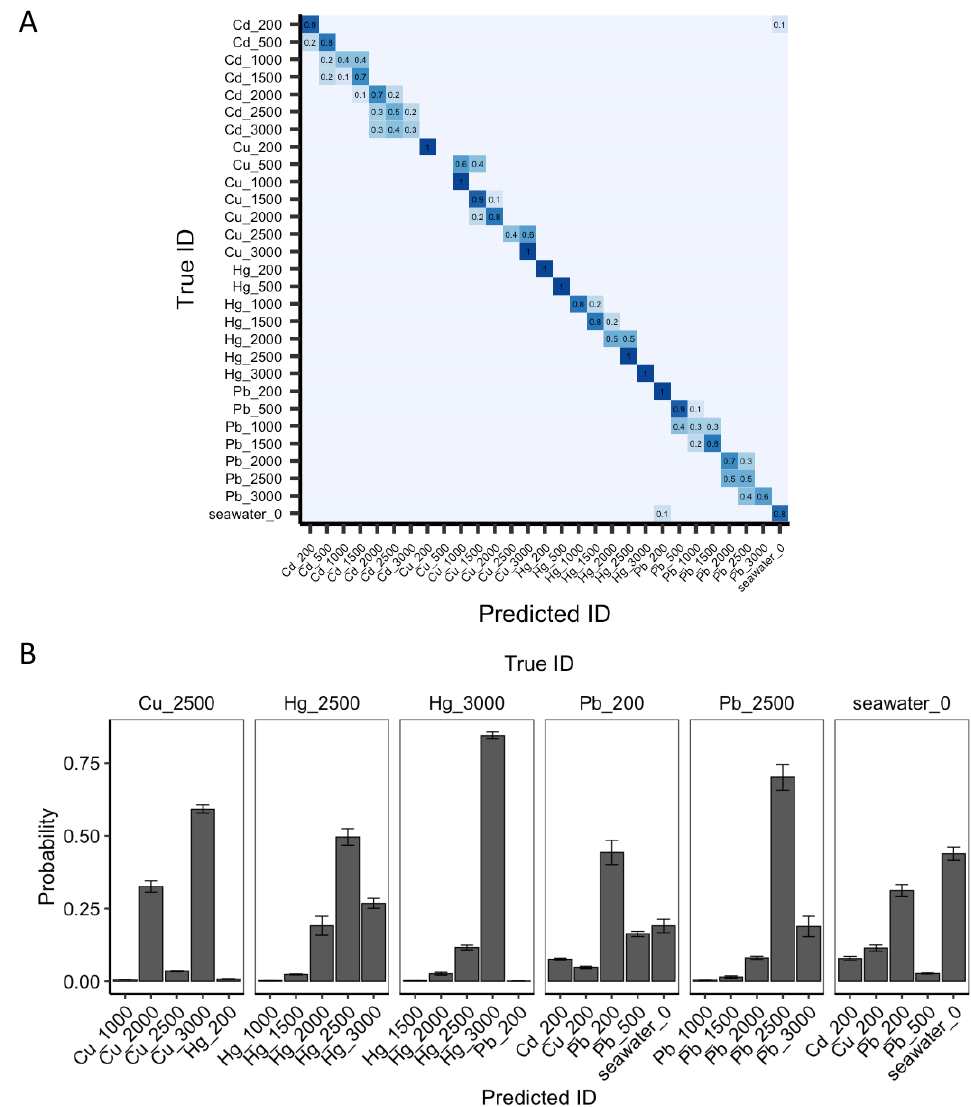
Figure 8. ML model prediction of concentration using oxygen modified hydrogen-intercalated QFS bilayer EG data. ( A ) Confusion matrix results using ALSTM-FCN to predict both metal salt and concentration. The prefix corresponds to the metal (or seawater) and the suffix is the concentration of metal salt in ppb. Probabilities of 0 are removed for clarity. ( B ) Evaluation of holdout dataset. Both identity and concentration of six samples selected at random (true IDs listed at the top) were evaluated for prediction performance. The top five predicted IDs according to probability for each sample are shown.